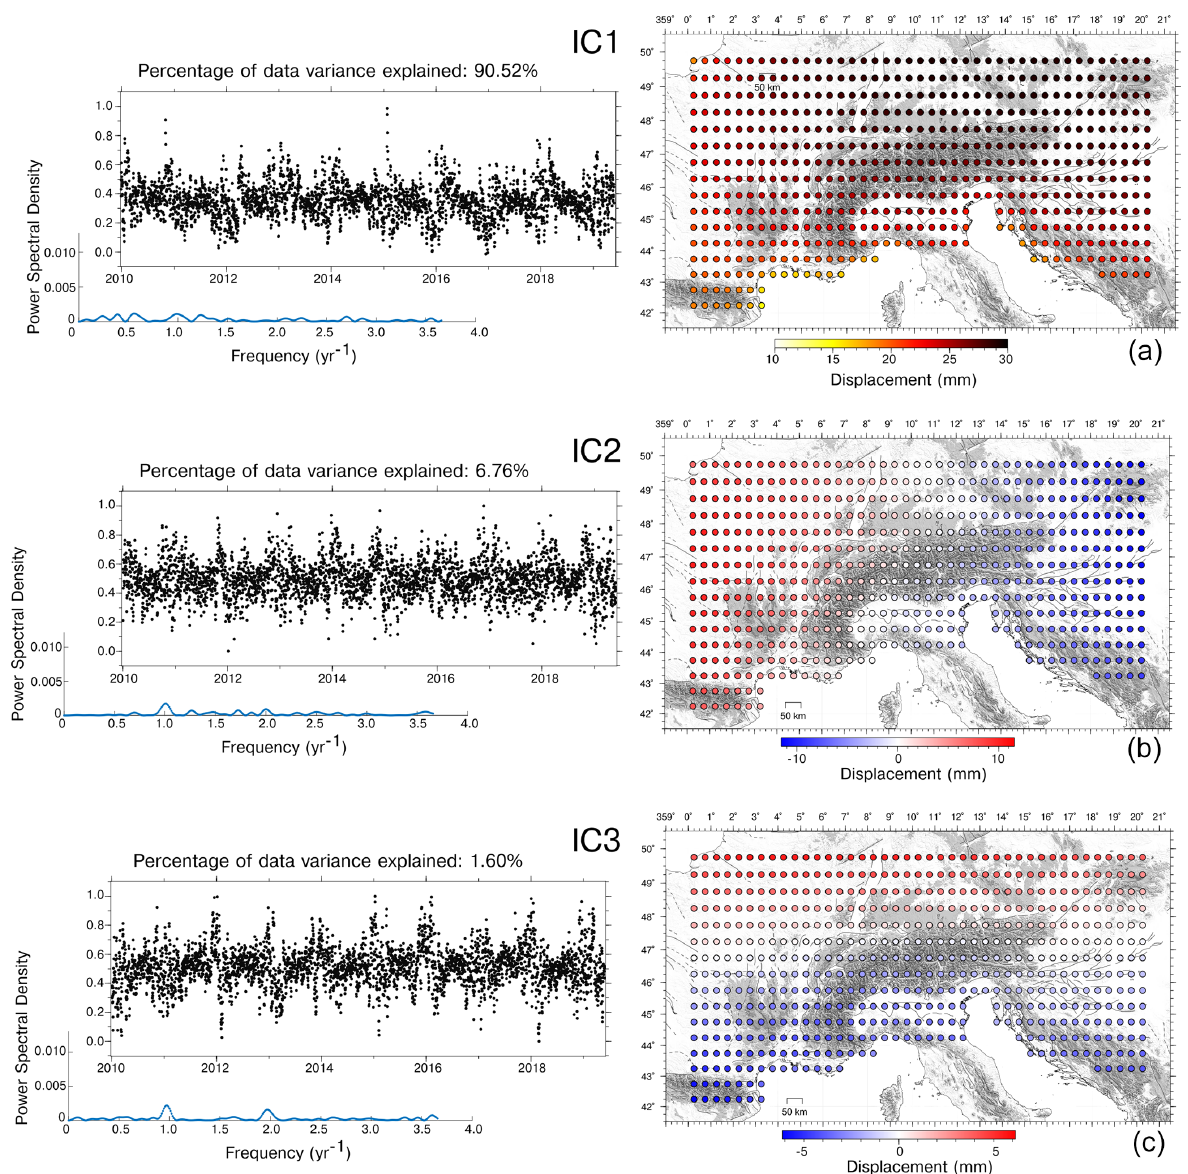
Figure 4. Temporal evolution, power spectral density and spatial response of IC1, IC2 and IC3 of the NTAL